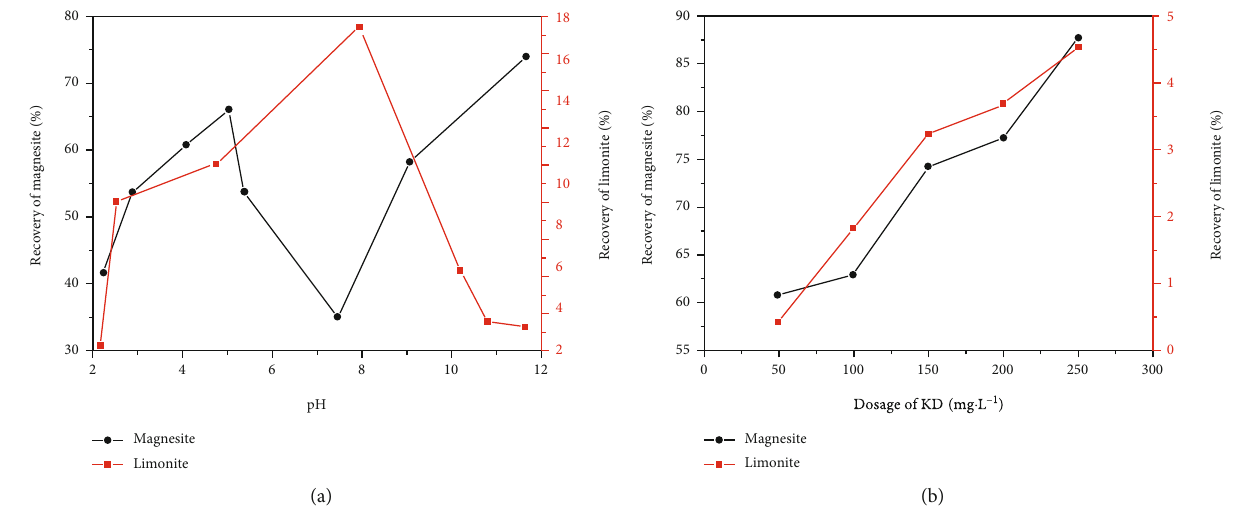
Figure 4: E ff ects of pH (a) and KD (b) on the fl otation rate of magnesite and